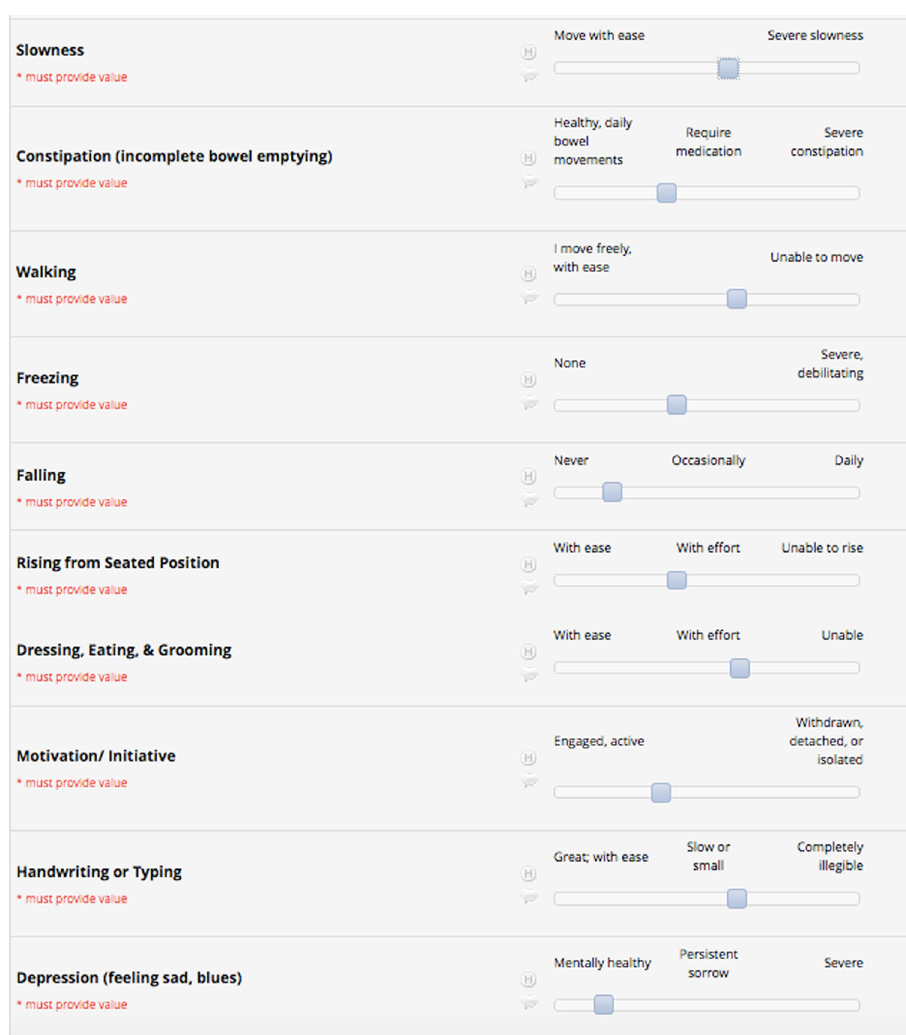
Fig. 3 Patient experience: Individuals touch anywhere on the bar to describe the severity of each symptom. The cumulative score of all 32 variables is the PRO-PD